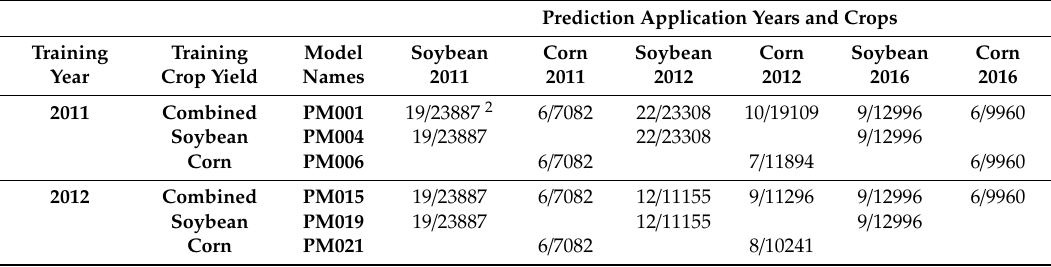
Table 5. Overview of the model scenarios and number of pixels and fields used in error analysis 1